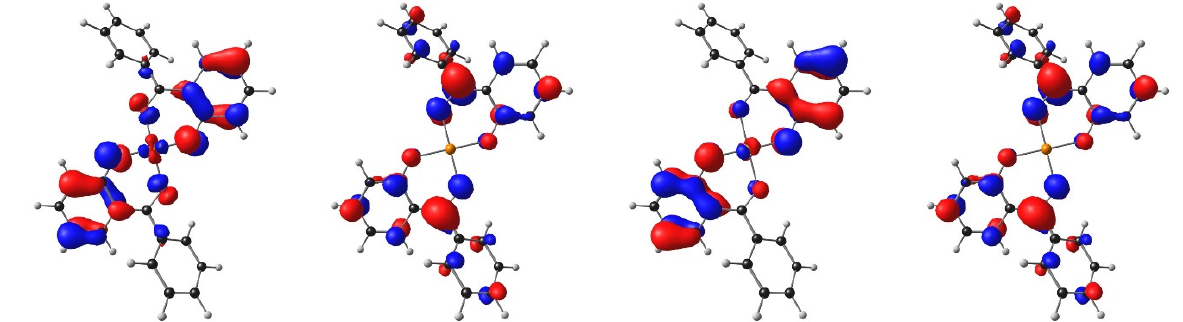
α -NTO particle (left)-hole (right) pair, occ 0.93 β - NTO particle (left)-hole (right) pair, occ 0.73 Figure 6. B3LYP/6-311G(d,p)/def2-TZVPP calculated NTOs involved in the calculated peak at 401.2 nm, corresponding to the experimental peak at 401 nm, of (5). The electron occupation of the occupied (particle) and unoccupied (hole) NTO pairs are indicated. A contour of 0.04 e/Å 3 was used for the orbital plot. Colour code of atoms (online version): Cu (orange), C (grey), O (red), H (white). Good agreement was obtained between the TDDFT calculated oscillators of band 2 and experimental absorbance maxima in this range (indicated in Table 1 and visualized in Figure 4). Complexes with electron withdrawing ligands (complexes ( 1 )–( 4 )) absorb light at